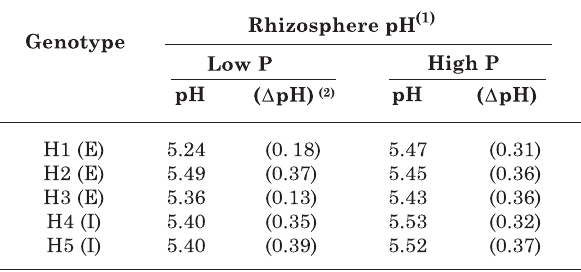
Table 6. Mean of rhizosphere pH values of roots maize genotypes grown at low and high soil